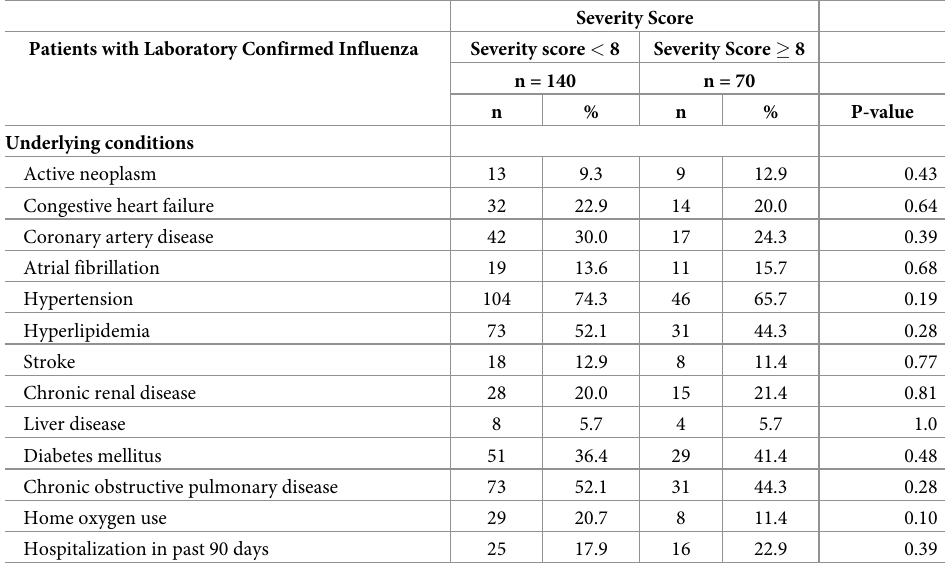
Table 5. Underlying conditions of hospitalized influenza-positive patients by severity